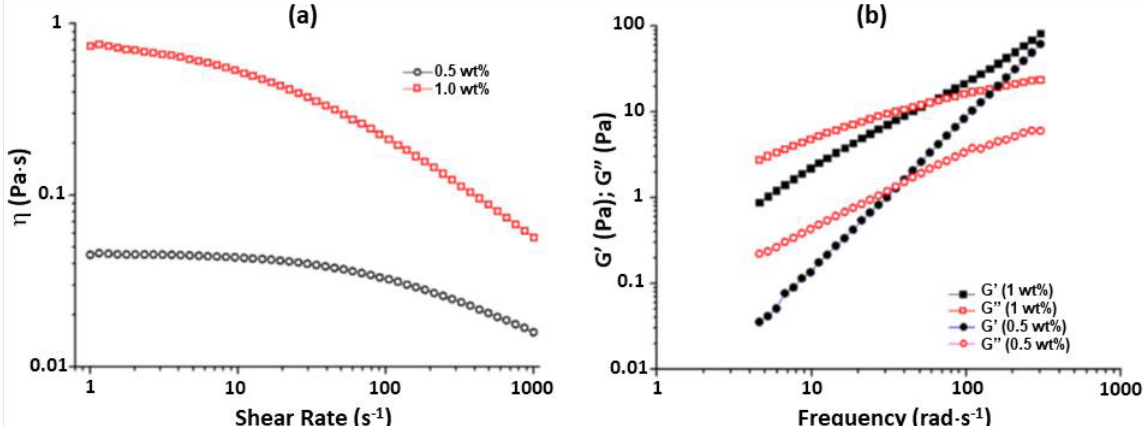
Figure 4. Viscosity ( a ) and viscoelastic properties (G ′ and G ″ elastic and viscous moduli, respec- tively) ( b ) of two XG aqueous solutions, at 0.5 and 1.0 wt% concentrations. (Adapted from [17], with permission from Elsevier.)